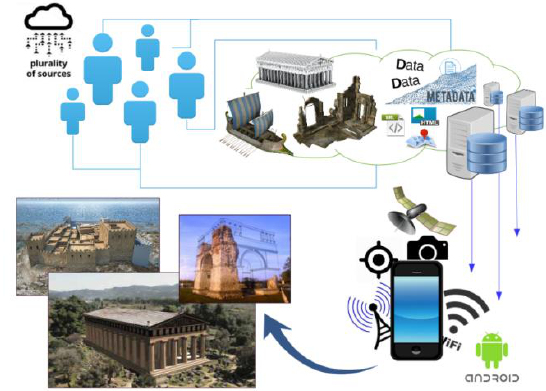
Figure 3. A lightweight presentation of the system operational architecture.